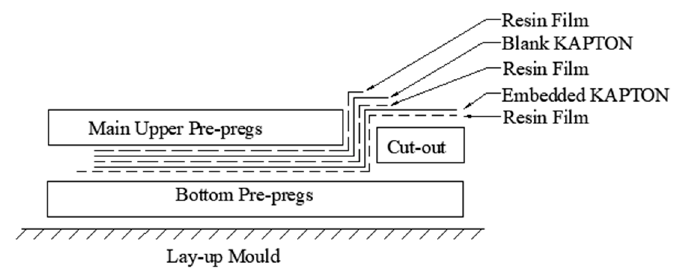
Figure 3. Schematic of the embedding procedure.